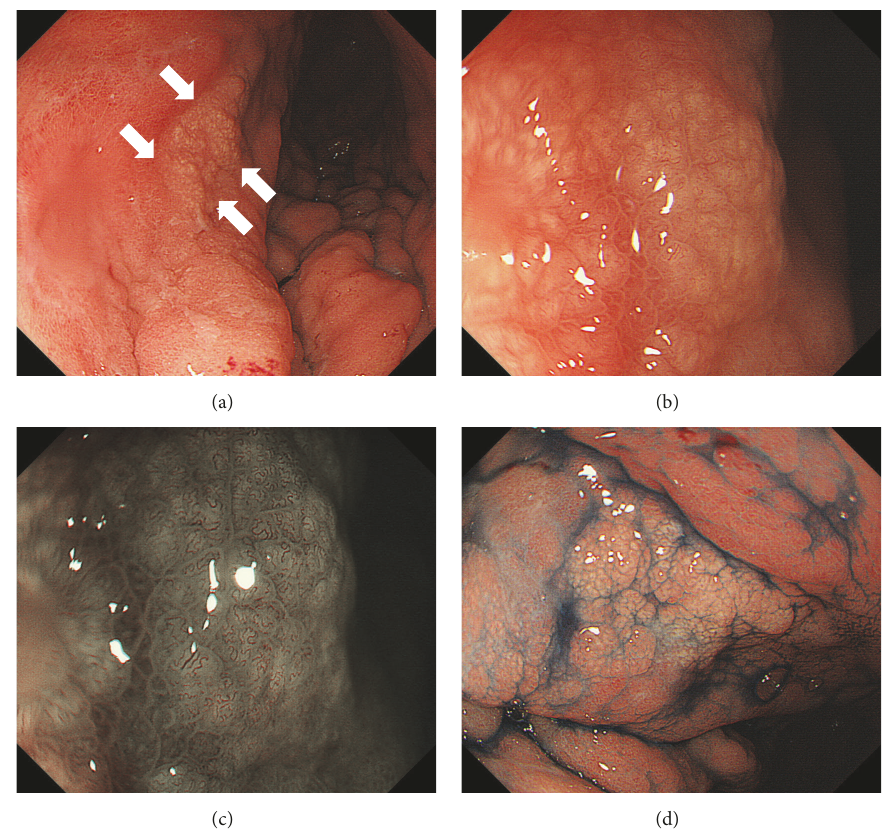
Figure 1: Esophagogastroduodenoscopy images. Slightly elevated, whitish lesions are observed in the gastric body ((a) arrows). Magnifying endoscopic observation with white light (b) and with narrow-band imaging (c) reveals that the gastric surface epithelium is swollen, but the structure is not destroyed or diminished. Whitish area is emphasized after indigo carmine spraying